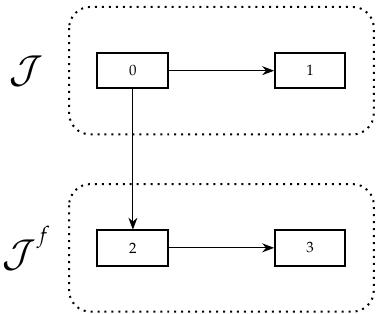
Figure 2. Survival model in the numerical